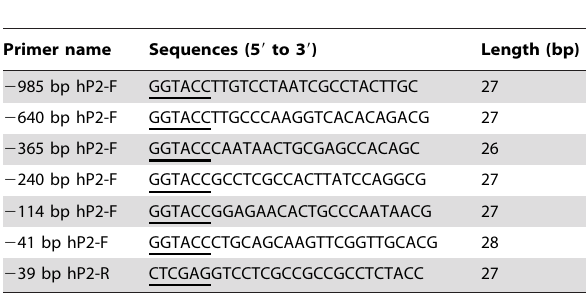
Table 1. Oligonucleotides used for construction of 5 9 - trucated hP2 promoter.